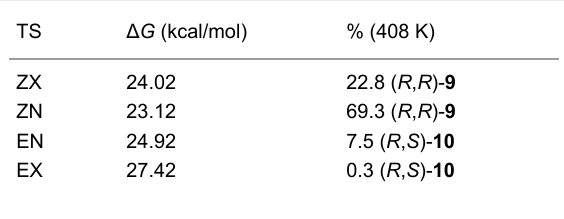
Table 2: Relative free energies of TSs and percentages of the corre- sponding adducts at 408 K of the reaction of dipolarophiles ( Z )- 8 and ( E )- 8 with nitrone 4